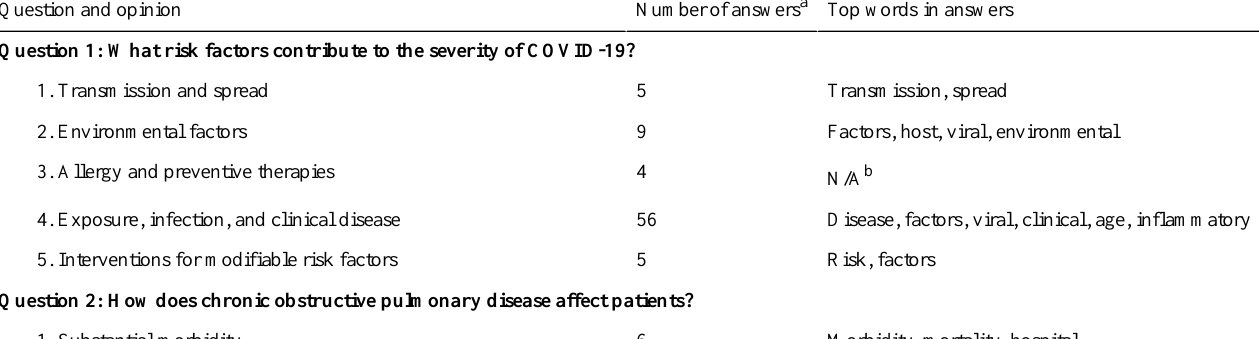
Table 1. Opinions, the number of answers supporting every question, and the words with the highest frequency for each opinion based on all articles. Question 1: What risk factors contribute to the severity of COVID-19?